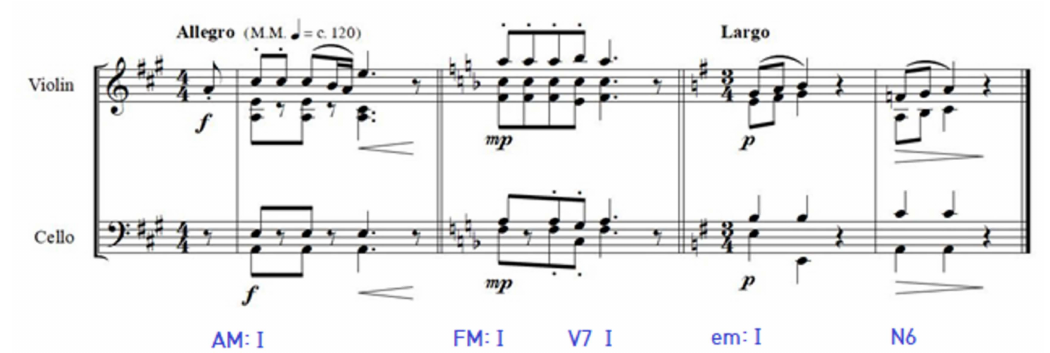
Figure 4. Modified scores for sound coding saturated (left), light (middle), and dark (right) colors played with a violin (same for trumpet and clarinet).